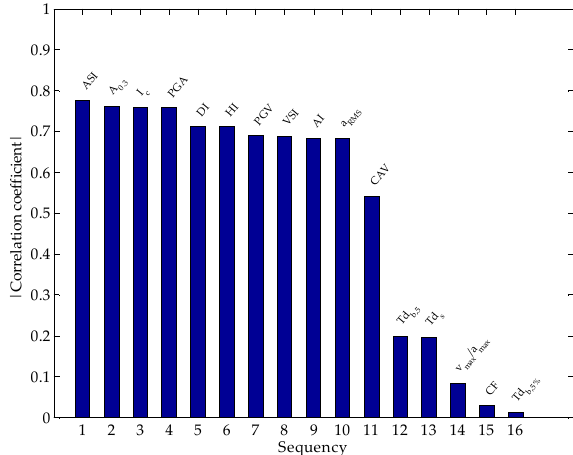
ffi cient for ground motion Figure 3. Absolute correlation coefficient for ground motion parameters. Figure 3. Absolute correlation coe Figure 3. Absolute correlation coefficient for ground motion parameters.